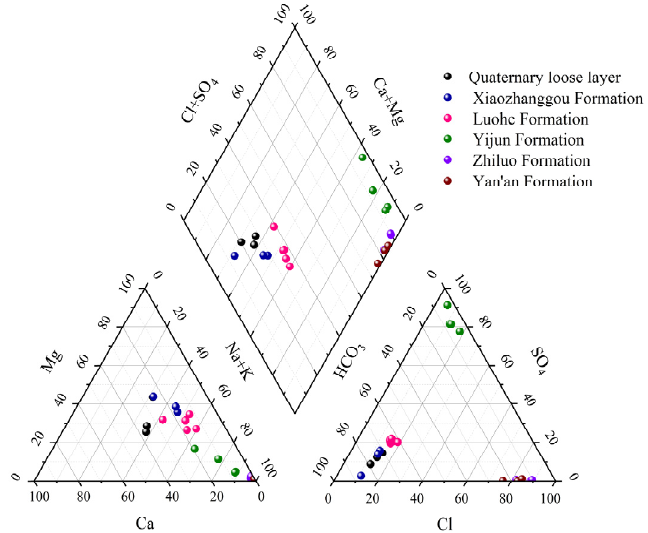
Figure 5. Hydrochemical type of groundwater.